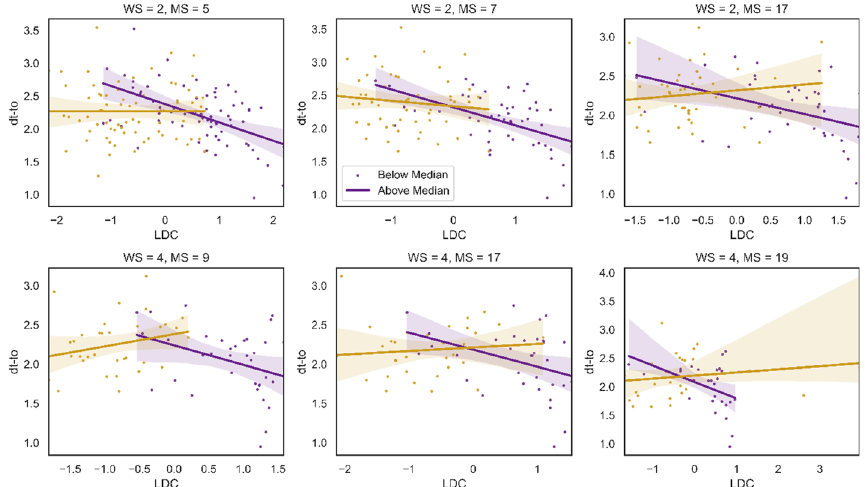
Fig. 13 Examples of interactions between LDC and average location on dt-to for WS: 2,4 and MS: 5,7,17. The x-axis denotes LDC, and the y-axis denotes